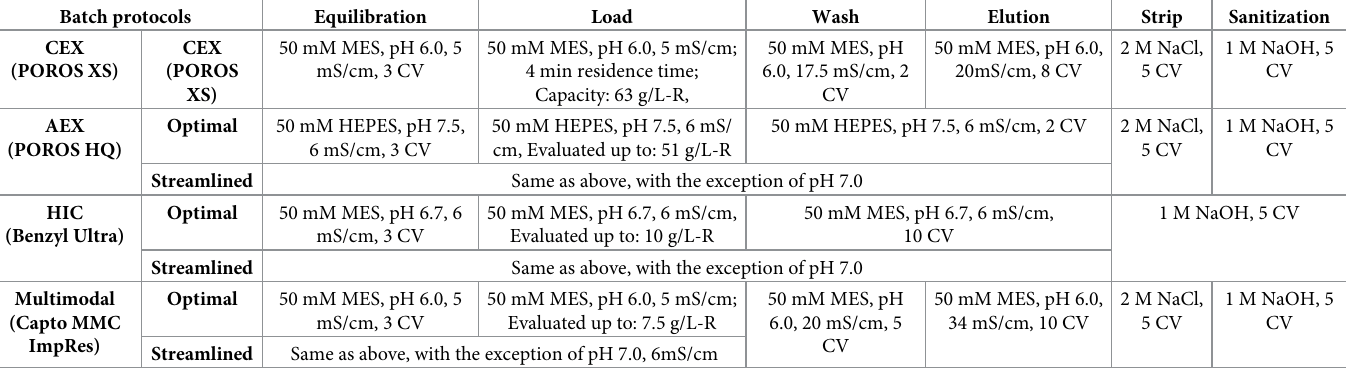
Table 2. Process parameters of CEX, AEX, HIC and multimodal chromatography batch protocols. A residence time of 2 min was used for all steps unless otherwise stated. Batch